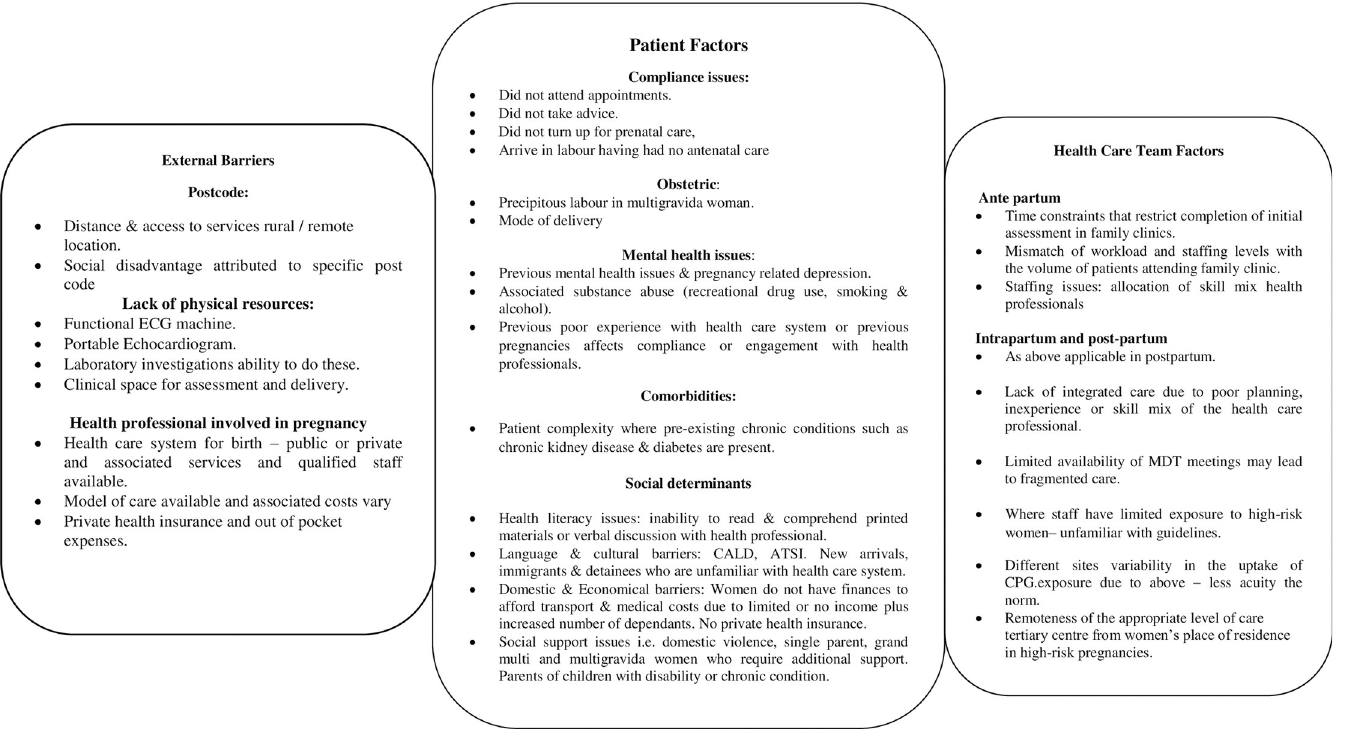
Fig 2. The factors that may influence the uptake of perinatal practice guidelines for women with cardiac conditions during pregnancy.